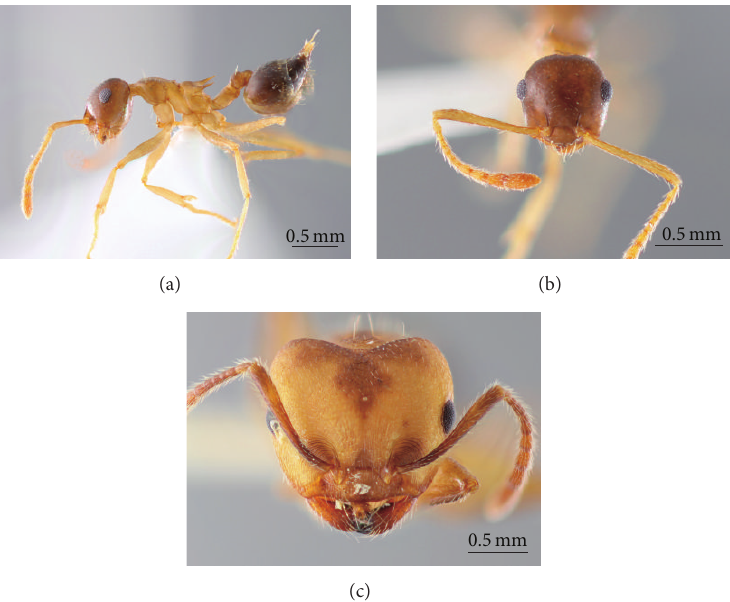
Figure 2: Crematogaster coriaria Mayr, 1872, worker. (a)–(c) Small worker (HW 0.64; WL 0.88) (Ulu Gombak, Selangor, Malaysia): (a) body in lateral view; (b) full-face view of head; (c) large worker having ocelli (HW 1.63; WL 1.58) (Cikaniki, Halimun, Java,